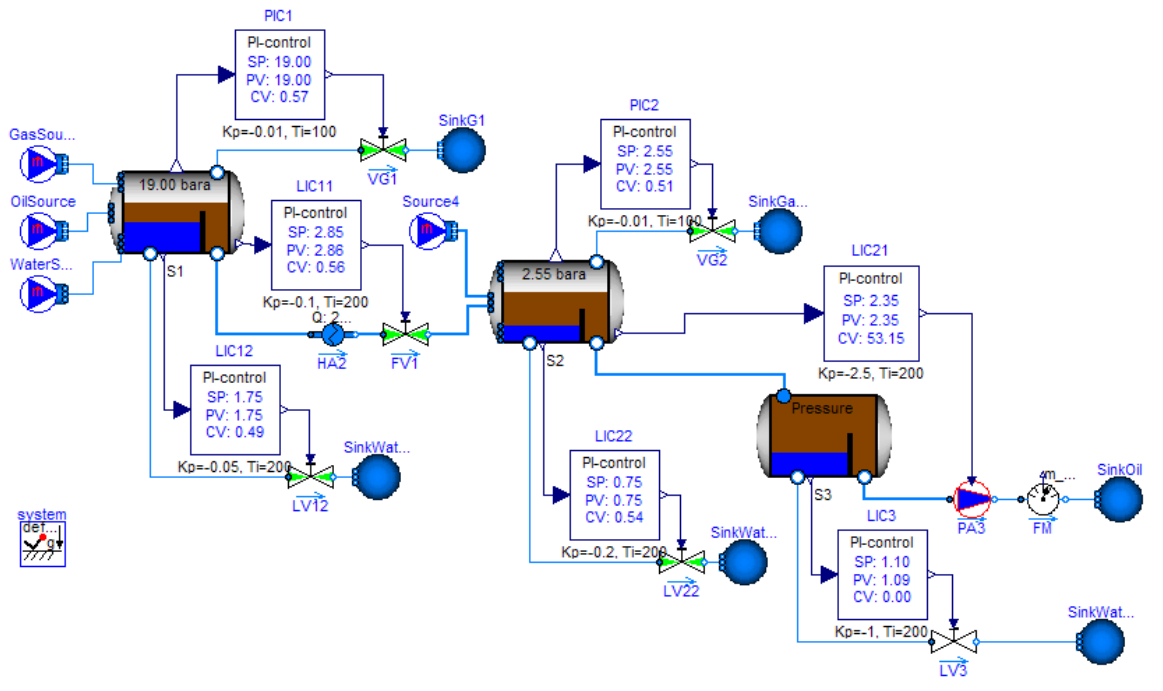
Figure 3: Overview of an offshore oil and gas processing plant, as implemented in